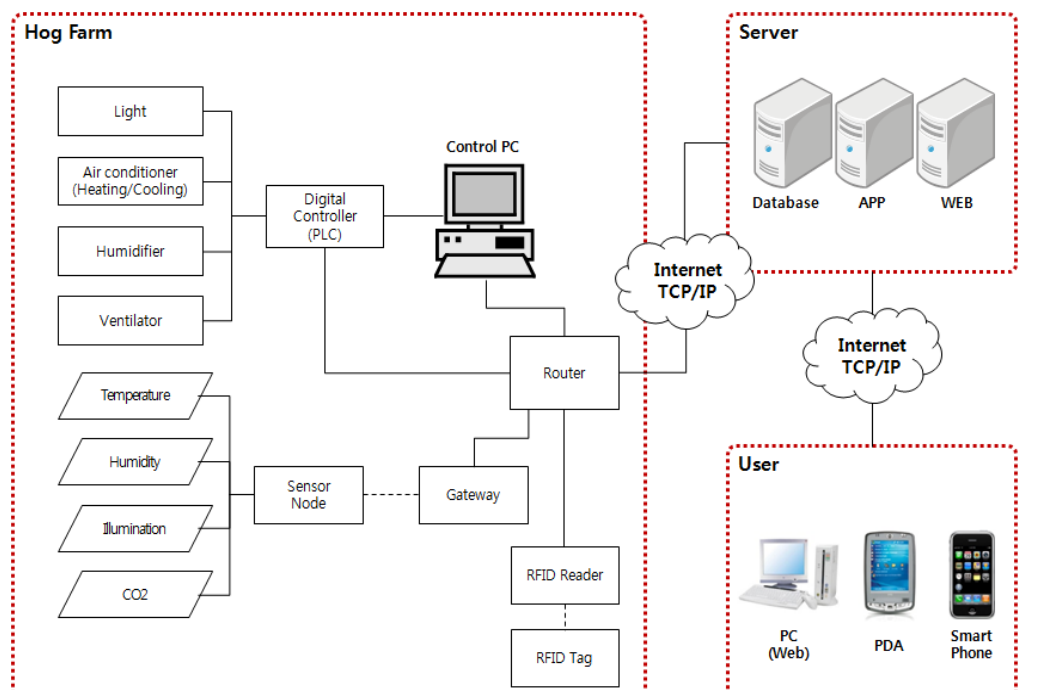
Figure 1. Hardware scheme of data acquisition and facilities